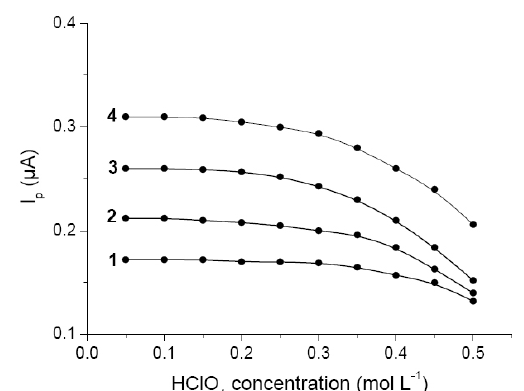
Figure 1. Relationship between the Hg(II) peak current obtained in DPASV and the HClO